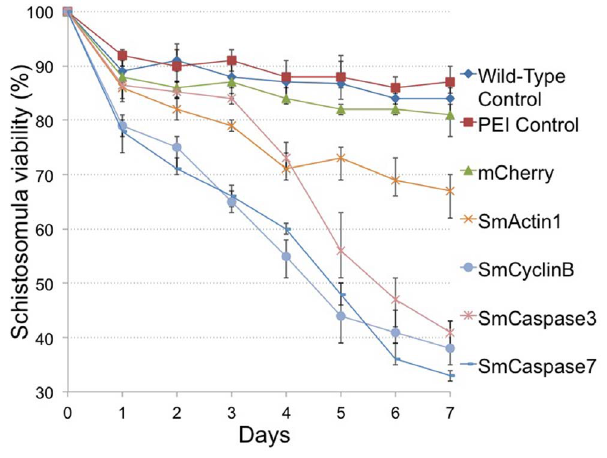
Figure 5. Gene specific overexpression affects schistosome viability. The mCherry gene, SmActin 1 gene, SmCyclin B gene, SmCaspase 3 and 7 genes were cloned under regulation of the SmActin promoter, and expressed in schistosomula for up to 7 days. Viability of schistosomula was assessed and quantified. Samples incubated with neither PEI or plasmid DNA (wildtype) or in the presence of PEI agent alone, were used as experimental controls. Data are shown as the mean percentage of surviving larvae from three biological replicates.